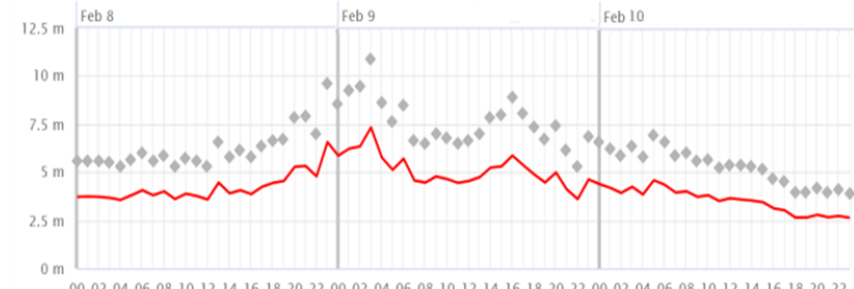
Figure 4. Significant wave height (red) and maximum wave height at Pasaia